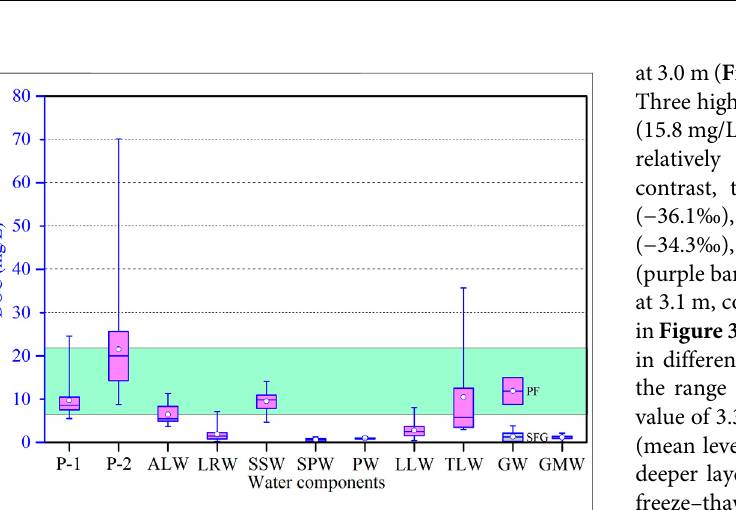
FIGURE 4 | Variations in DOC and δ 13 C DOC of ground ice and (total organic carbon) TOC of soil along depth in P-2. The pink bars represent four peaks of DOC in ground ice and the corresponding values of δ 13 C and TOC soil . The blue bars denote the lower DOC and more negative δ 13 C values.